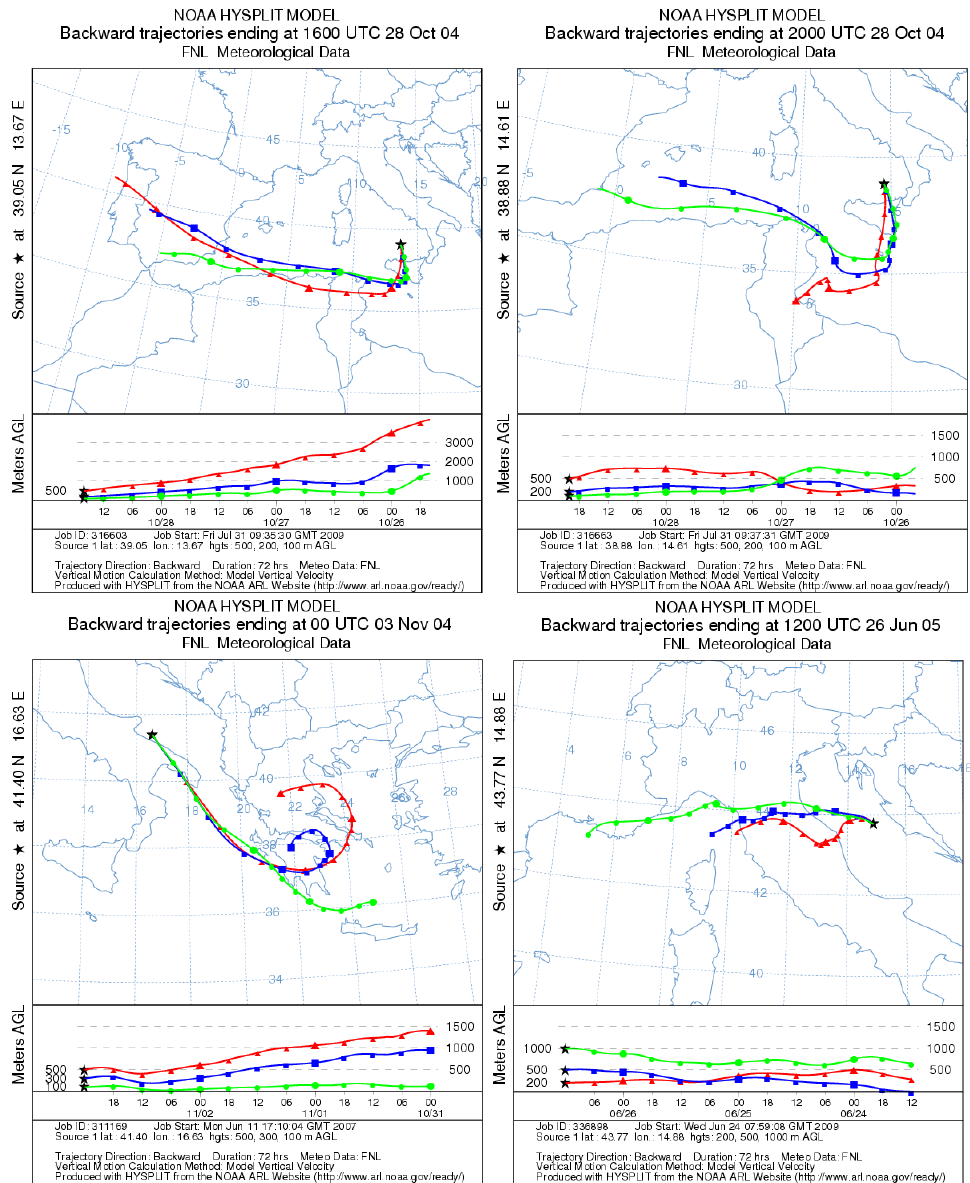
Fig. 4. Some of the back trajectories calculated using HYSPLIT (Draxler and Rolph, 2003; Rolph,